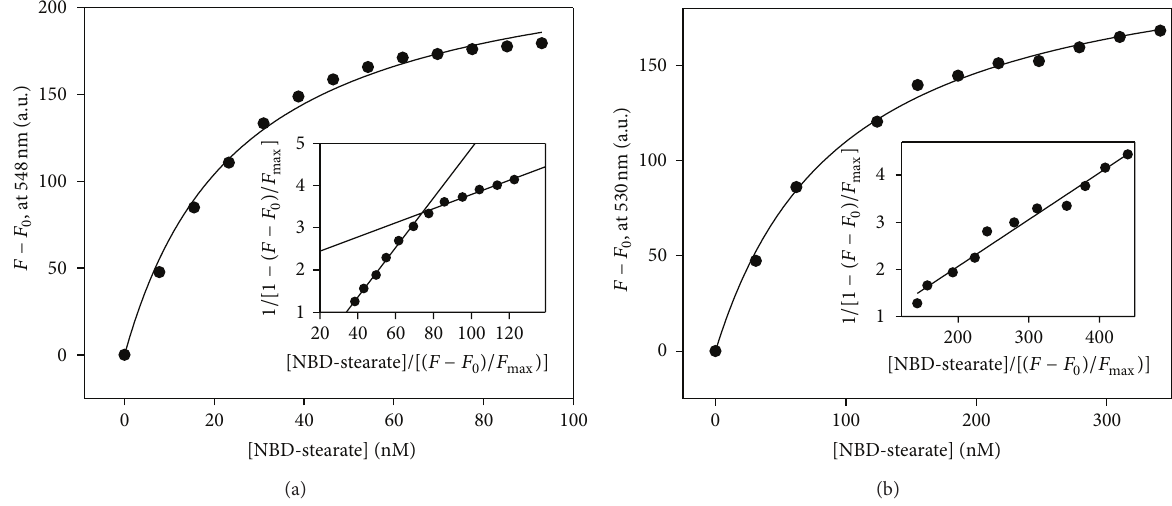
Figure 2: Representative binding curves of stearic acid binding to L-FABP (panel a) and SCP2 (panel b). NBD-stearic acid binding curves were obtained as described in Methods. Briefly, a 2 mL sample of L-FABP (25nM) or SCP-2 (25nM) in 10mM phosphate buffer (pH 7.4) was titrated with small increments of NBD stearate at 24 ∘ C (Methods). NBD-stearate fluorescence emission spectra (515–600 nm) were recorded with 490nm excitation. 𝐹 : fluorescence intensity of NBD stearate in the presence of proteins (at 530 nm for binding to SCP-2 and at 548 nm for binding to L-FABP) and 𝐹 0 being NBD-stearate fluorescence intensity in buffer (at the same wavelength as for 𝐹 ). Insets are double reciprocal plots of the fluorescence binding data in the same